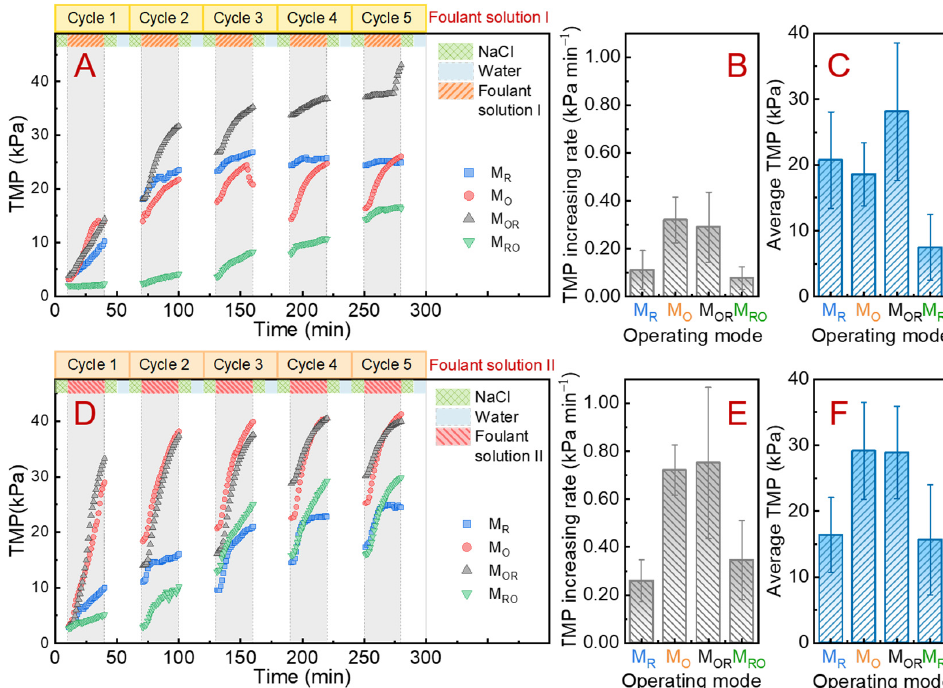
Figure 4. Comparison of antifouling performance in terms of ( A ) TMP variation, ( B ) TMP increasing rate, and ( C ) average TMP among the different operating modes (i.e., M R , M O , M OR , and M RO ) with the synthetic foulant solution I (Table 1). Comparison of antifouling performance in terms of ( D ) TMP variation, ( E ) TMP increasing rate, and ( F ) average TMP among the different operating modes with the synthetic foulant solution II (Table 1).